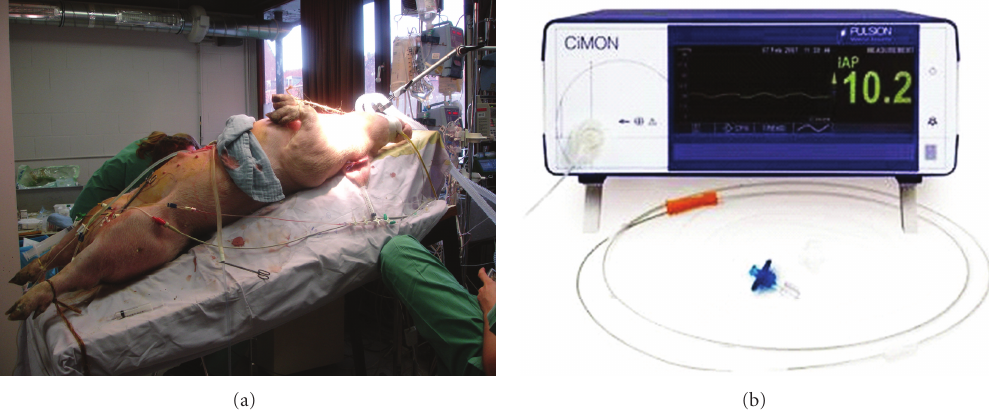
Figure 1: (a) Pig setup in head of bed (HOB) 25 ◦ in animal lab at Leuven University. (b) CiMON monitor and probe with feeding